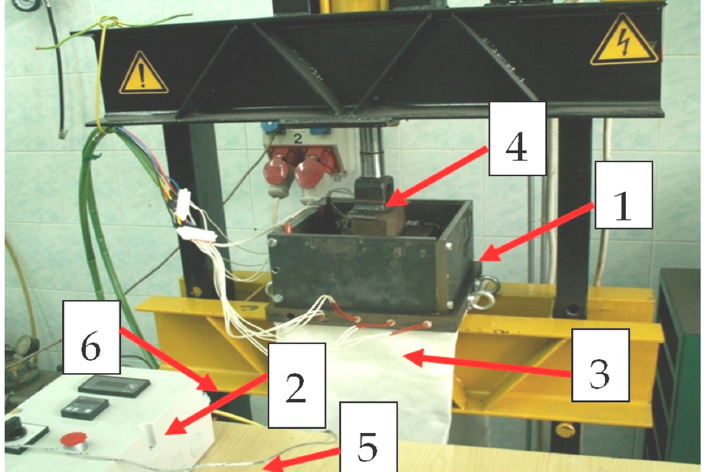
Figure 3. Test station for the production of plates obtained from the recycling of cable waste: 1—metal mould, 2—heating system with temperature control, 3—resistance heaters, 4—pressure pin of the hydraulic cylinder, 5—control thermo-couple cable, 6—base of the hydraulic